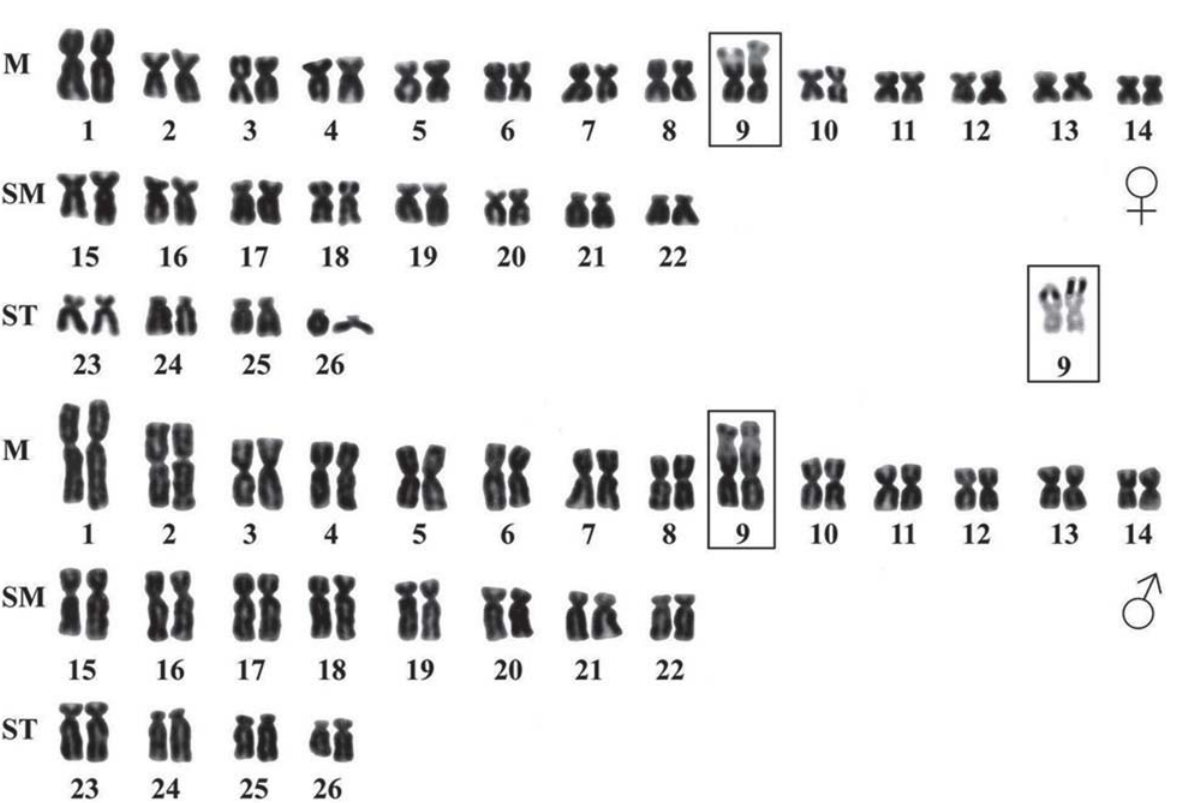
Fig. 1. Karyotypes of female and male of Pterygoplichthys joselimaianus with conventional Giemsa staining. The chromo- some pair bearing Ag-NORs are in the